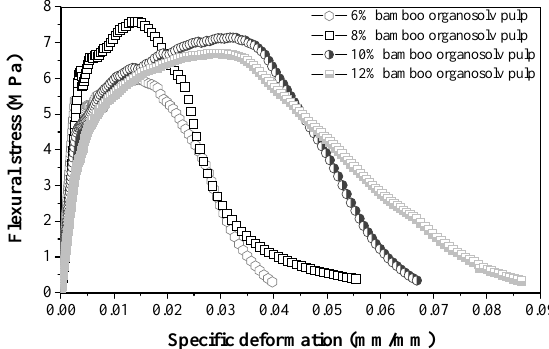
Figure 5. Typical stress ‐ strain curves of the composites containing 6, 8, 10 and 12% bamboo organosolv pulp during flexural tests after 8 days of thermal curing. Adapted from